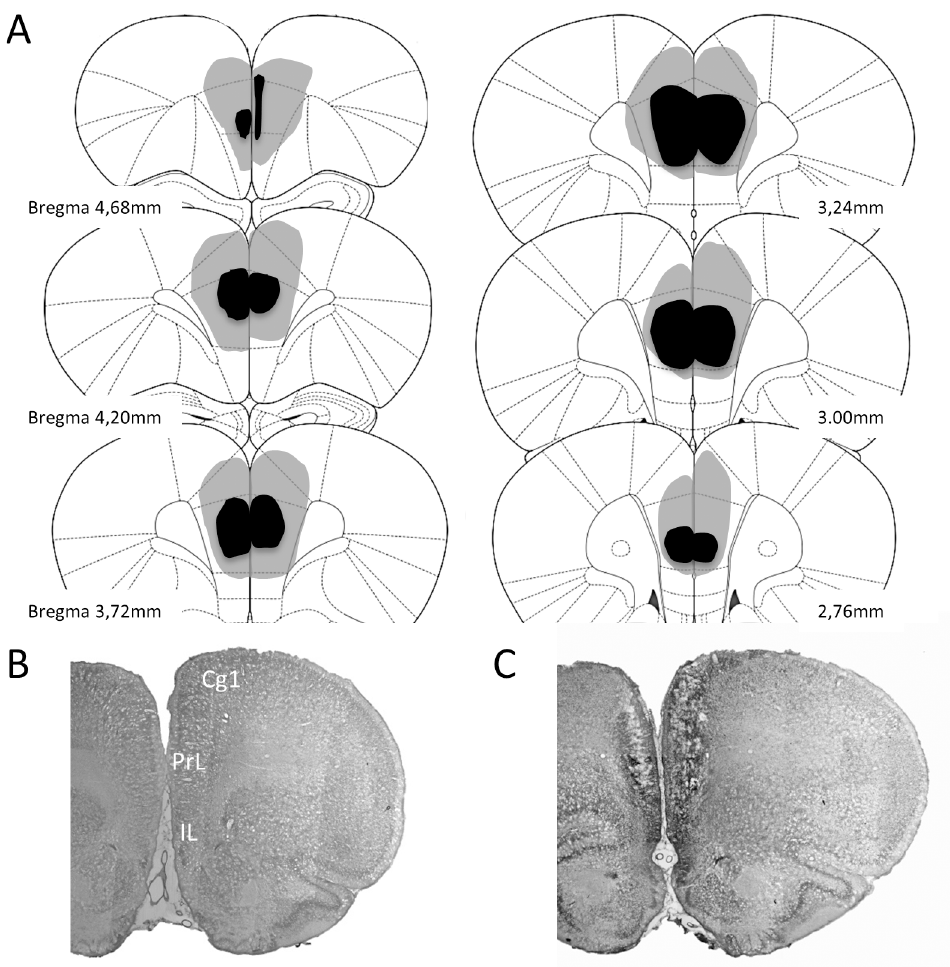
Fig 2. A. Reconstruction of the mpfc lesions. Similar to dls lesion, the largest and smallest lesionare shown in pale and dark shadingrespectively. B and C . show photomicrograph of a no lesionedcoronal brain section and another one with a excitotoxic lesionof mpfc. Cg1: cingulatecortex, area 1; IL: infralimbiccortex; PrL: prelimbic